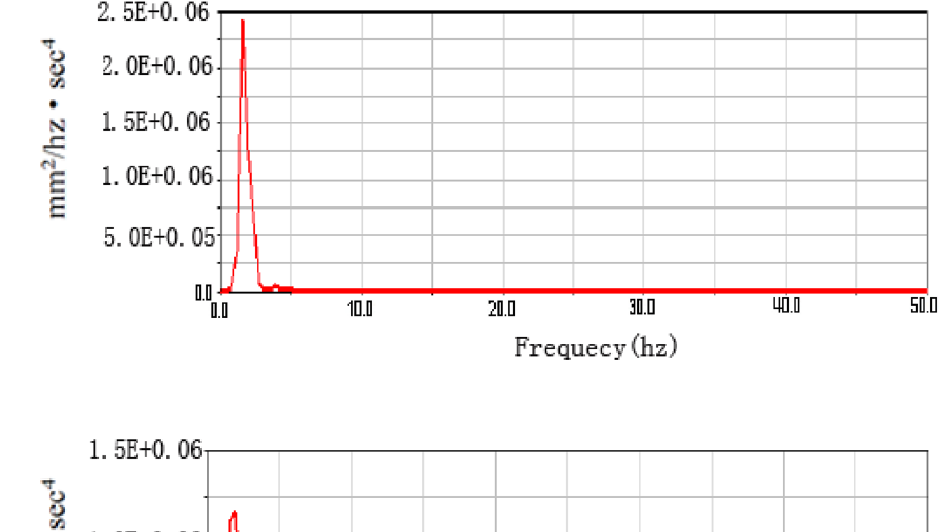
Fig. 10 Test 5. Acceleration Response Curve